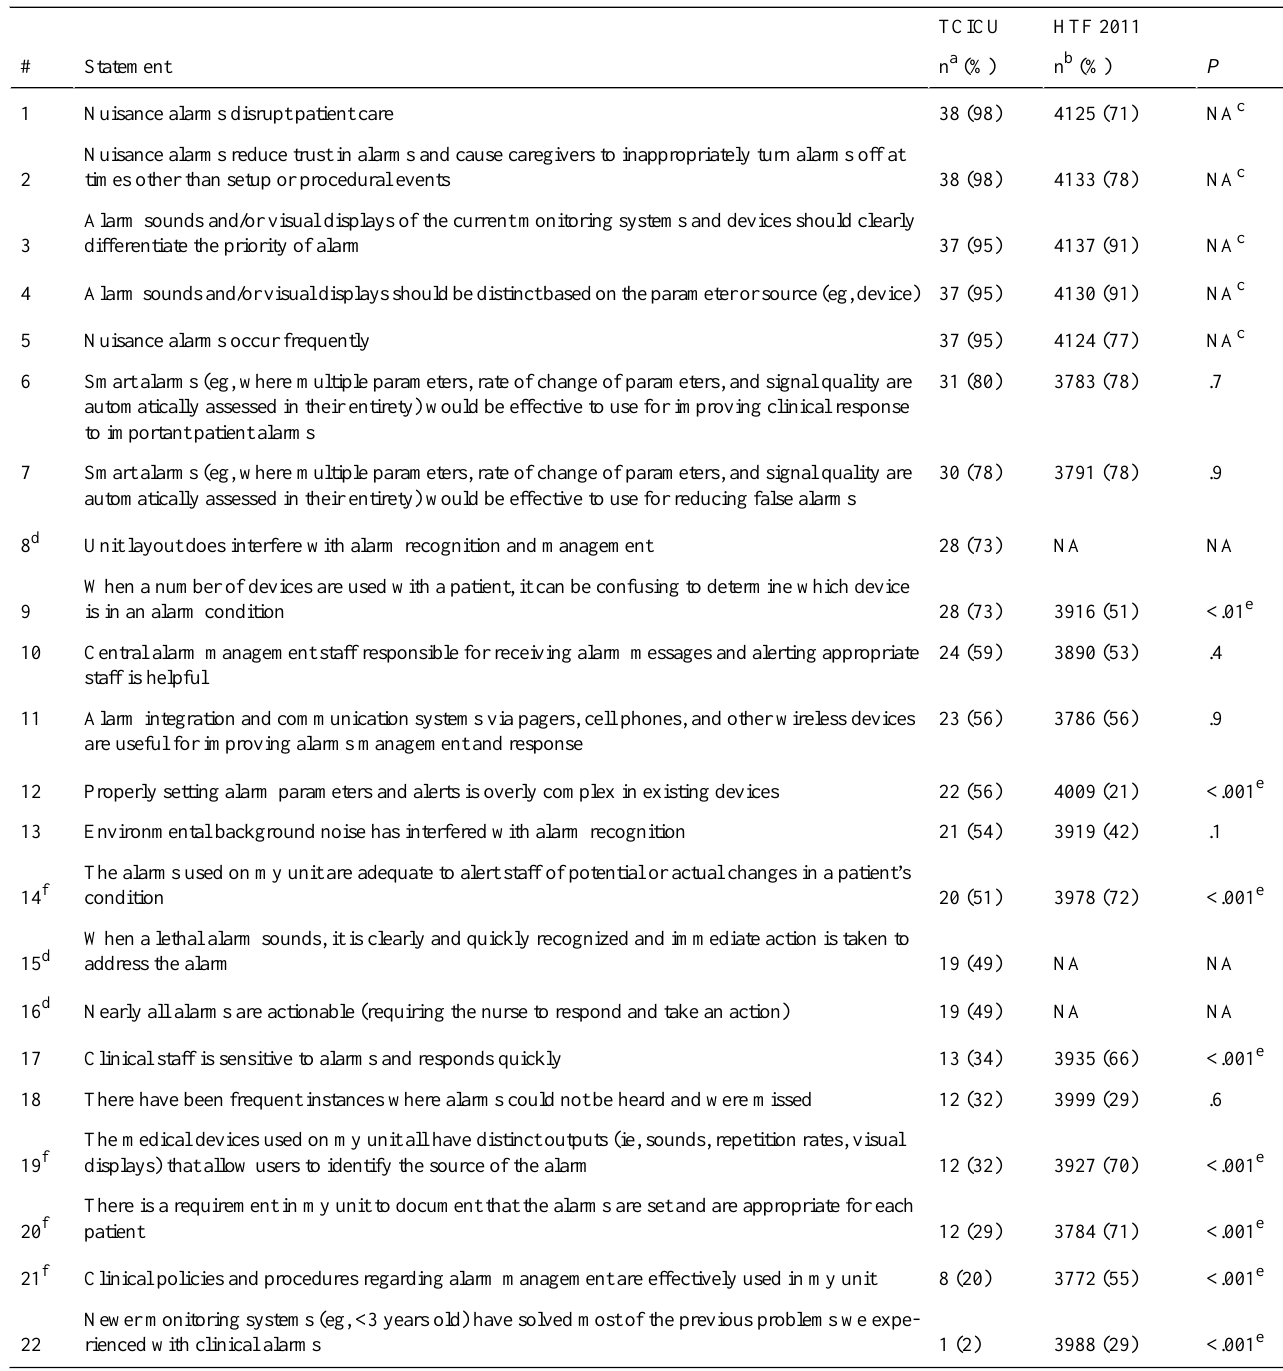
Table 1. Percentages of TCICU nurses who agreed or strongly agreed on clinical alarm survey statements compared with respondents of the 2011 HTF survey